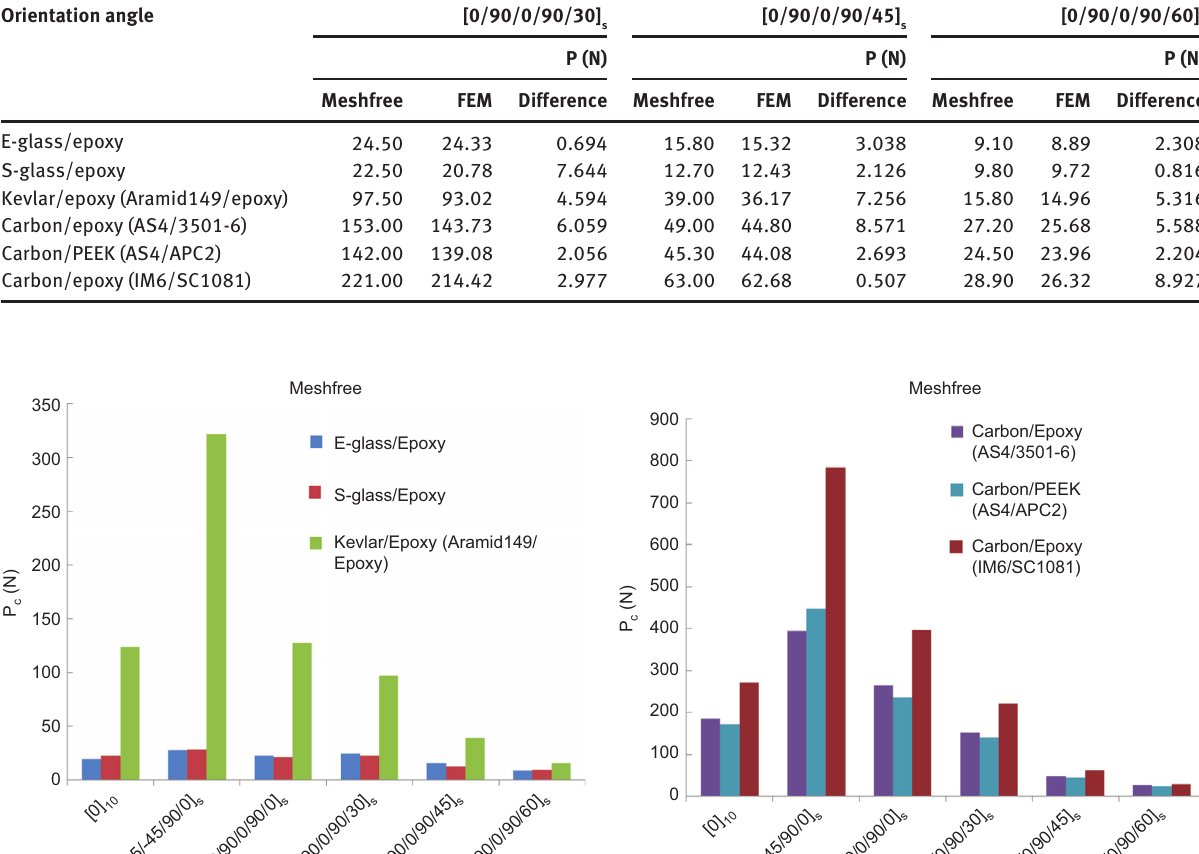
Table 5 Results of the meshfree and finite element methods (continuous). Orientation angle